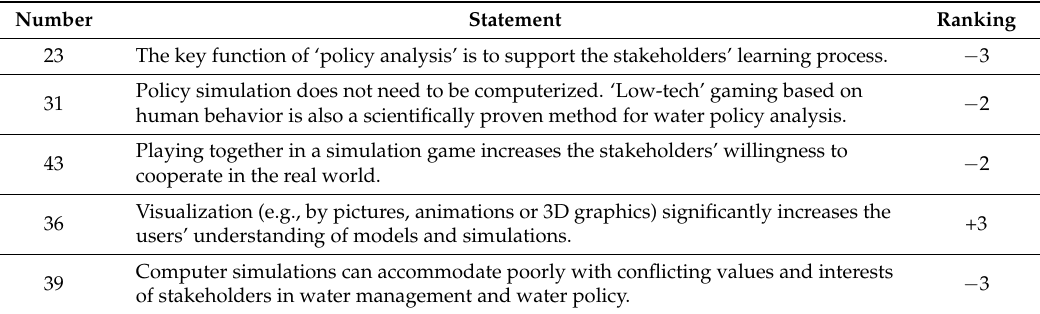
Table 2. Distinguished statements about MSG in frame